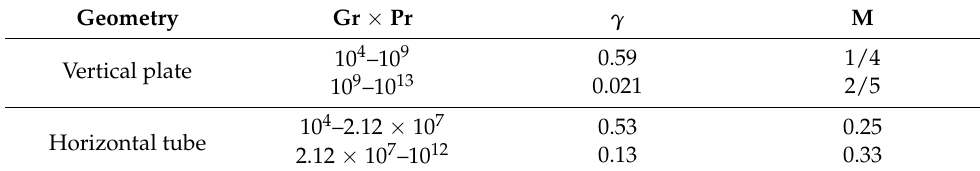
Table 1. Correlations for the calculus of Nusselt number